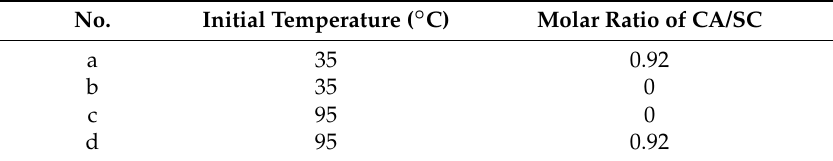
Table 2. Synthesis conditions to obtain lead citrate crystals in CA/SC solutions.